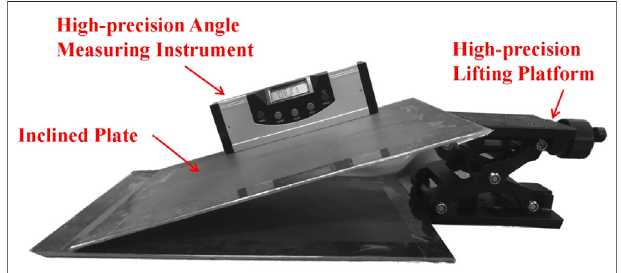
FIGURE 2 | Inclined test